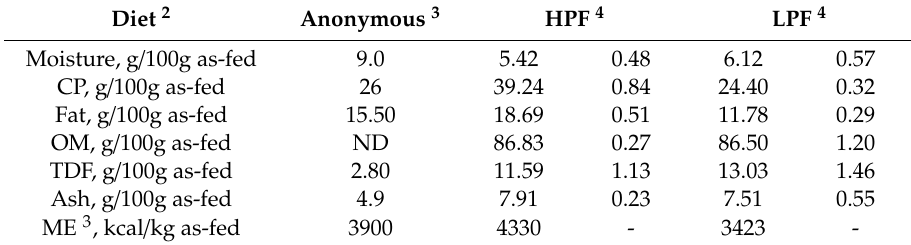
Table 1. Chemical composition and metabolizable energy of the diets 1